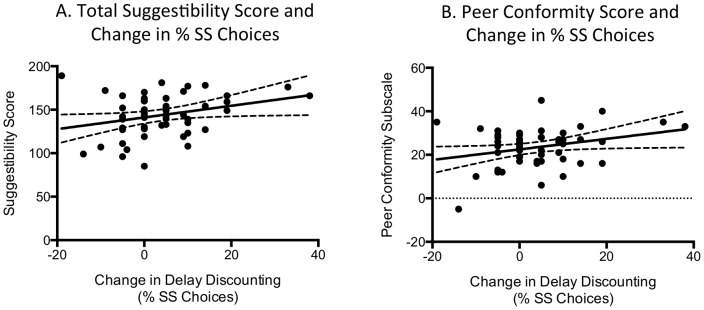
Associations between percentage of SS choices and (A) MISS total suggestibility score and (B) Peer Conformity Subscale score.Dotted lines represent the 95% confidence interval of the associations.